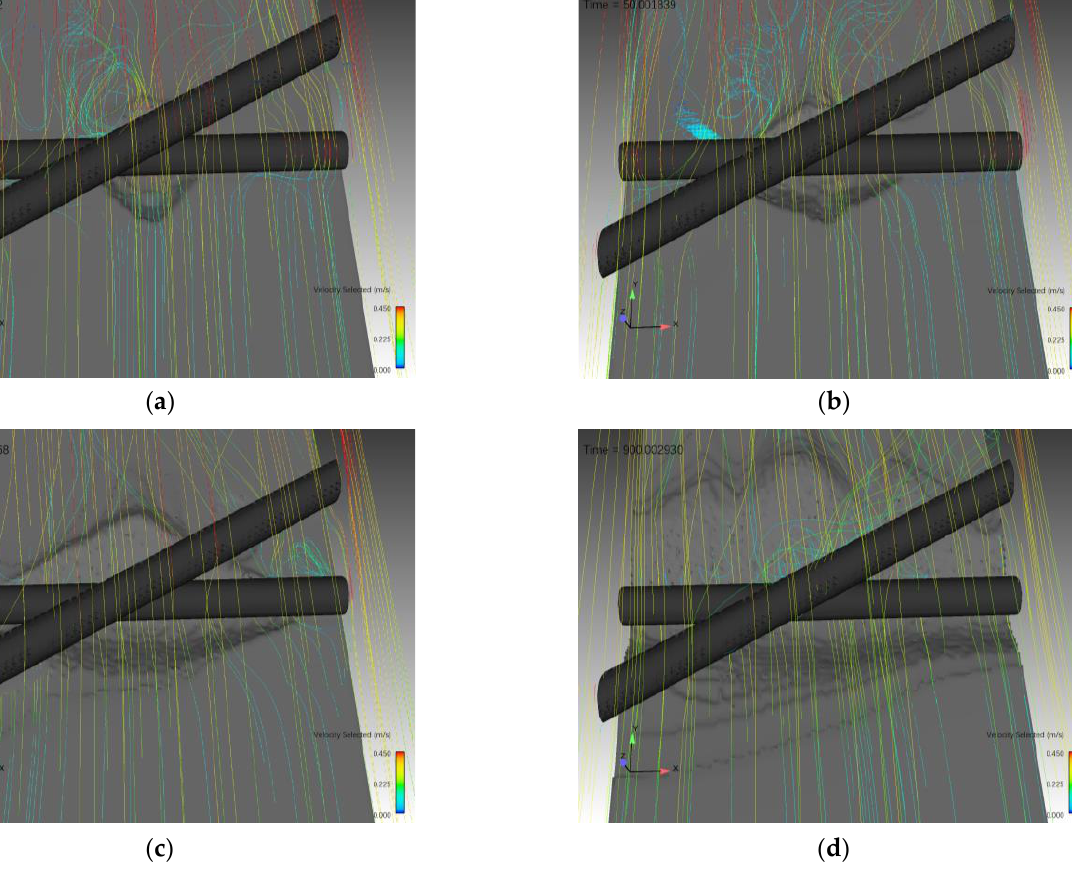
Figure 12. Streamlines around the pipelines for α = 30°: ( a ) t = 10 s; ( b ) t = 50 s; ( c ) t = 200 s; ( d ) t = 900